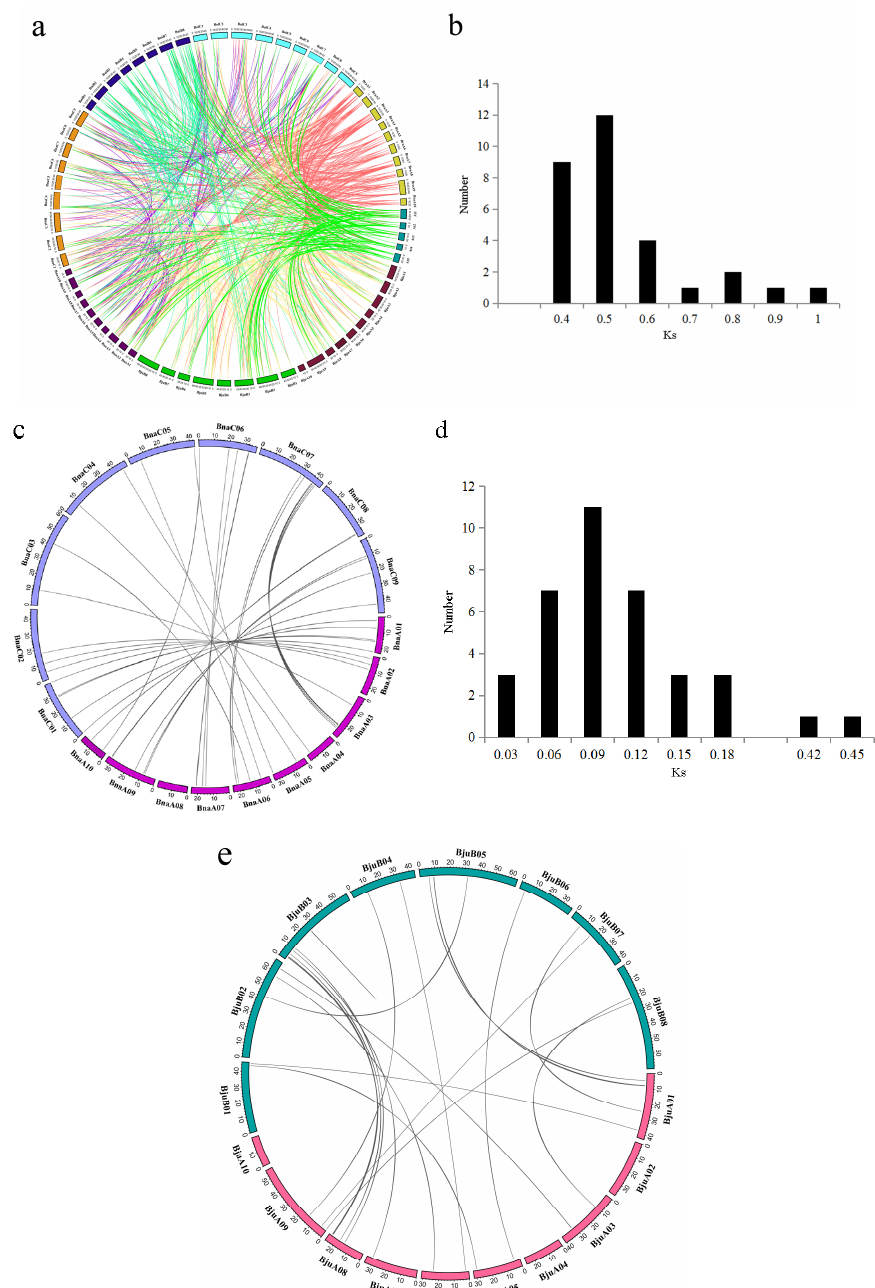
Figure 3. Duplicated and orthologous genes in the Brassicaceae. ( a ) Circle plot of orthologous genes in A. thaliana (At), B. oleracea (Bol), B. rapa (Bra), B. napus (Bna), B. juncea (Bju), and B. nigra (Bni). ( b ) Density of K s values of MATE gene pairs between B. napus and A. thaliana . ( c ) Duplicate gene pairs in B. napus . ( d ) Density of K s values of duplicated MATE genes in B. napus . ( e ) Duplicate gene pairs in B. juncea .